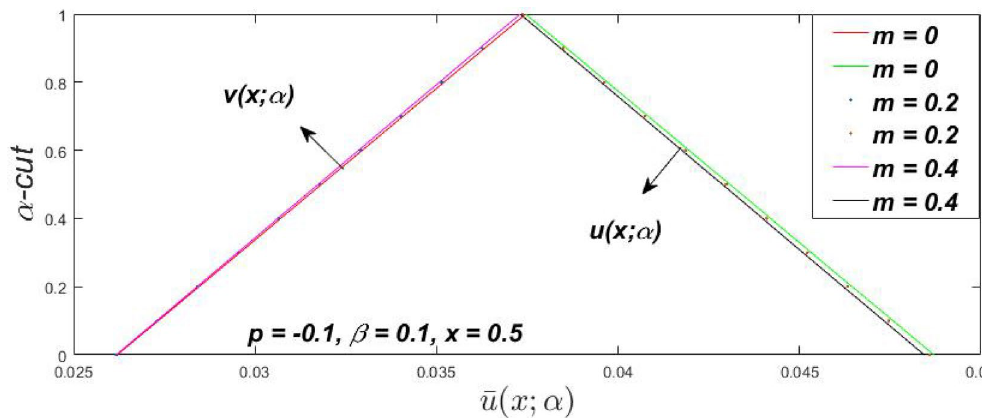
Figure 26. Triangular MF of fuzzy velocity for the impact of m .